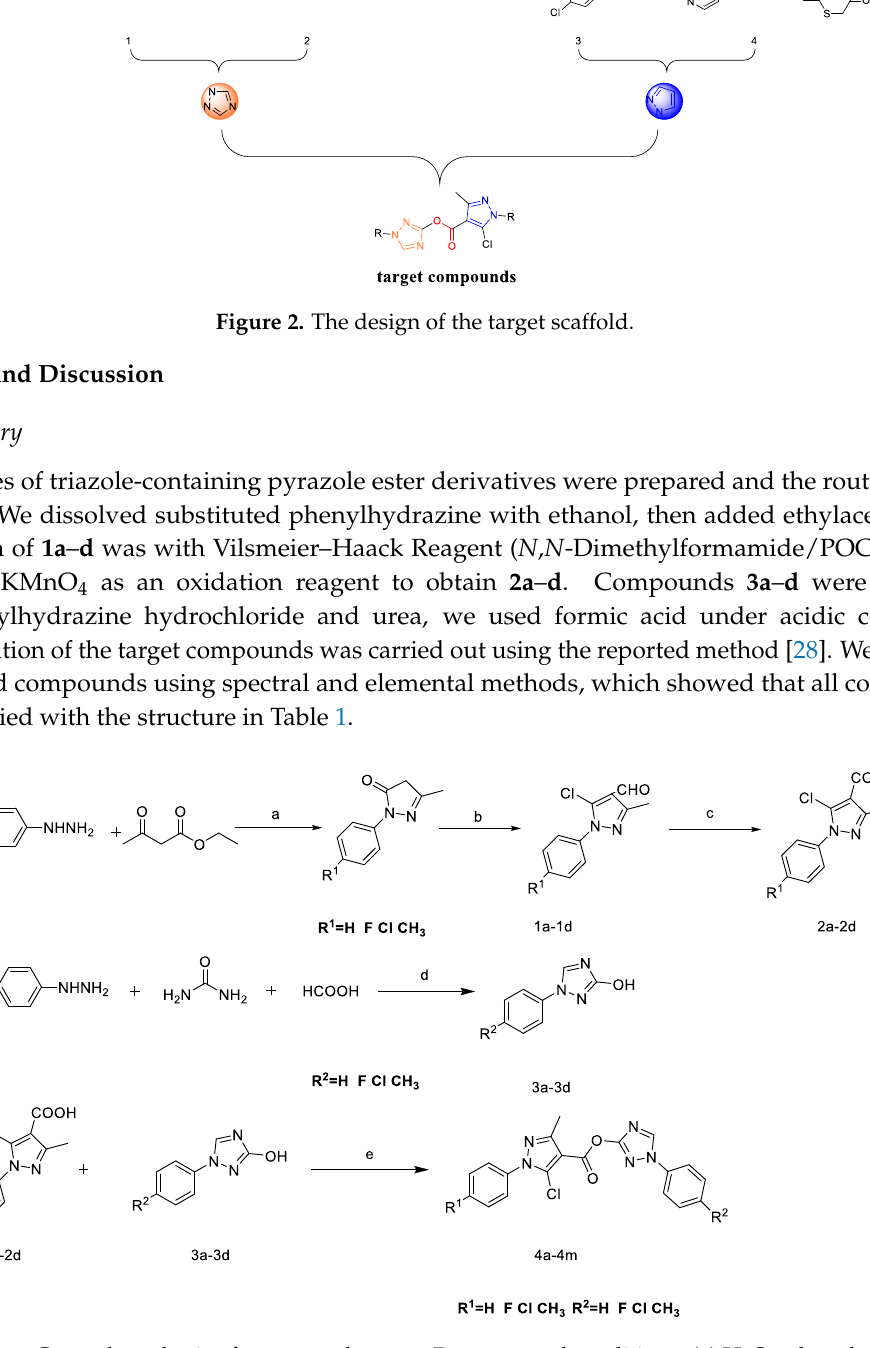
Table 1. Minimum inhibitory concentration (MIC) of all compounds against bacteria.